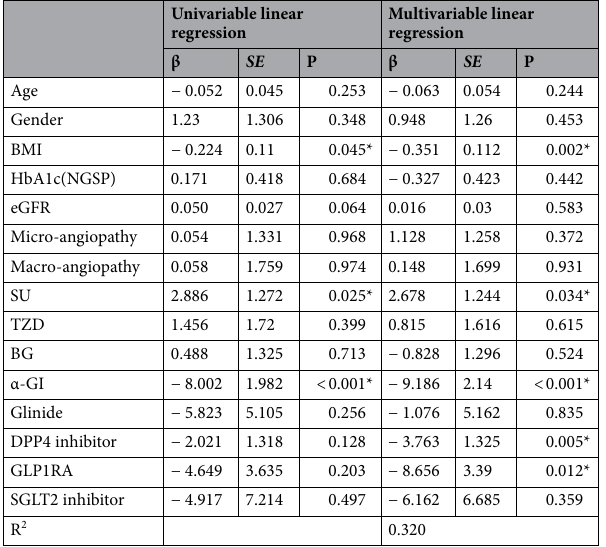
Table 3. %CV analyzed by single and multiple linear regression analyses. β regression coefficient, SE standard error. *p < 0.05.